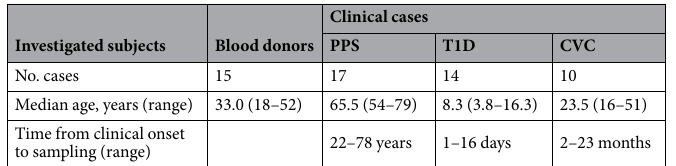
Table 3. Demographic data of control blood donors and patients diagnosed either with Post-Polio Syndrome (PPS), Type 1 Diabetes (T1D), or Chronic Viral Cardiomyopathy